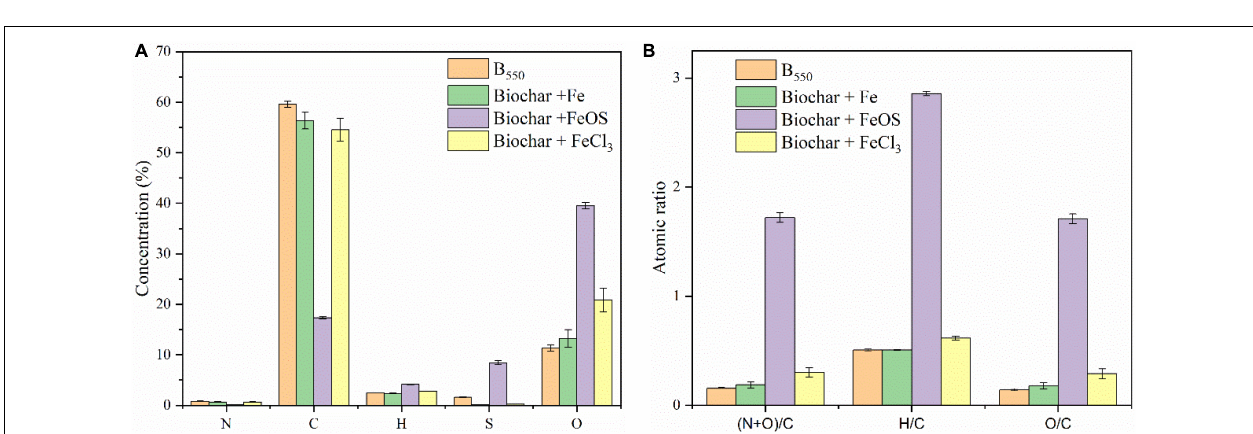
FIGURE 1 | FTIR spectra for the pristine biochar and iron-modified biochar (A) and pH value of soil before and after biochar amendment (B) .